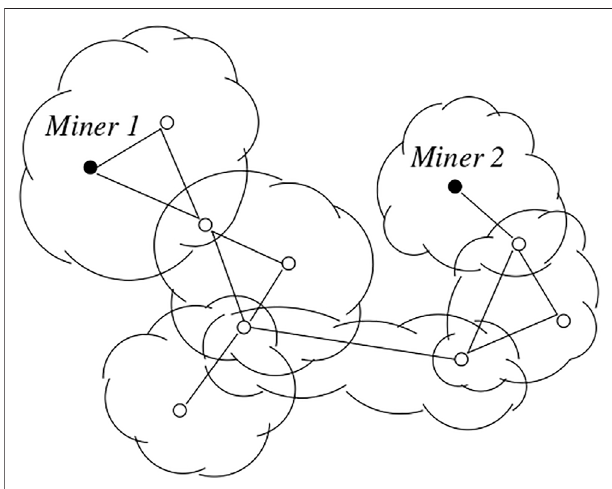
FIGURE 1 | Example of P2P network with 6 communities; some representative peers are depicted, including 2